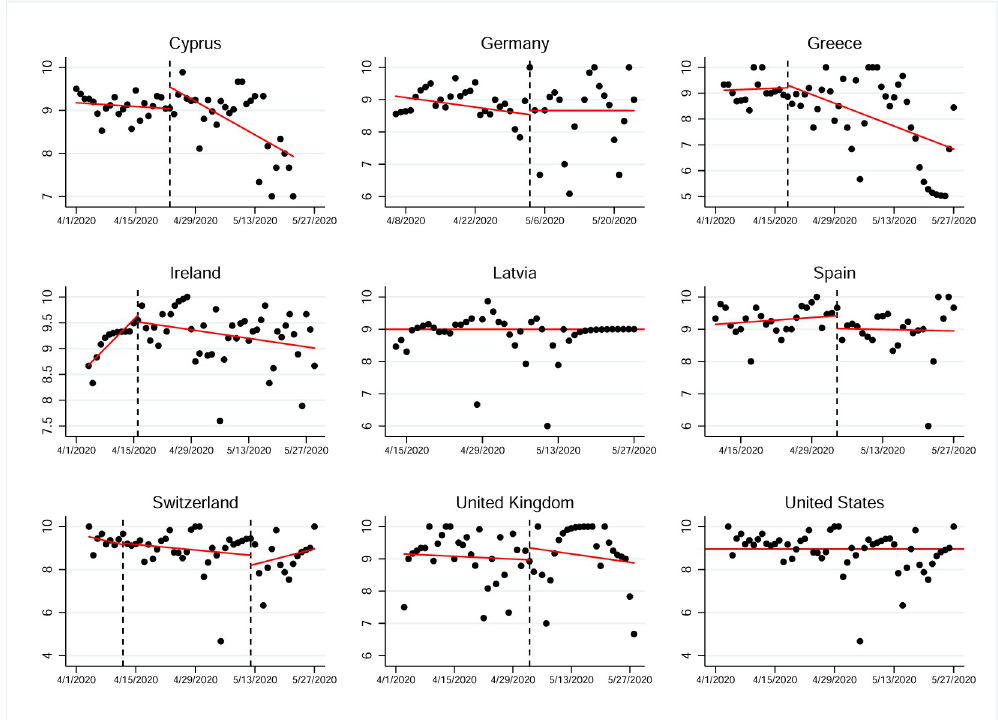
Fig 5. Interrupted time series analysis for self-protective behaviors using significant variation in COVID-19 cases as the intervention date (dashed horizontal line). https://doi.org/10.1371/journal.pone.0284433.g005 considered by policymakers when introducing new or changing existing guidelines [32].